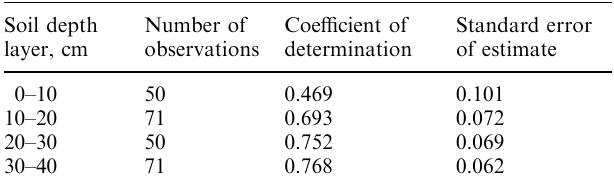
(cid:134)(cid:134) tr